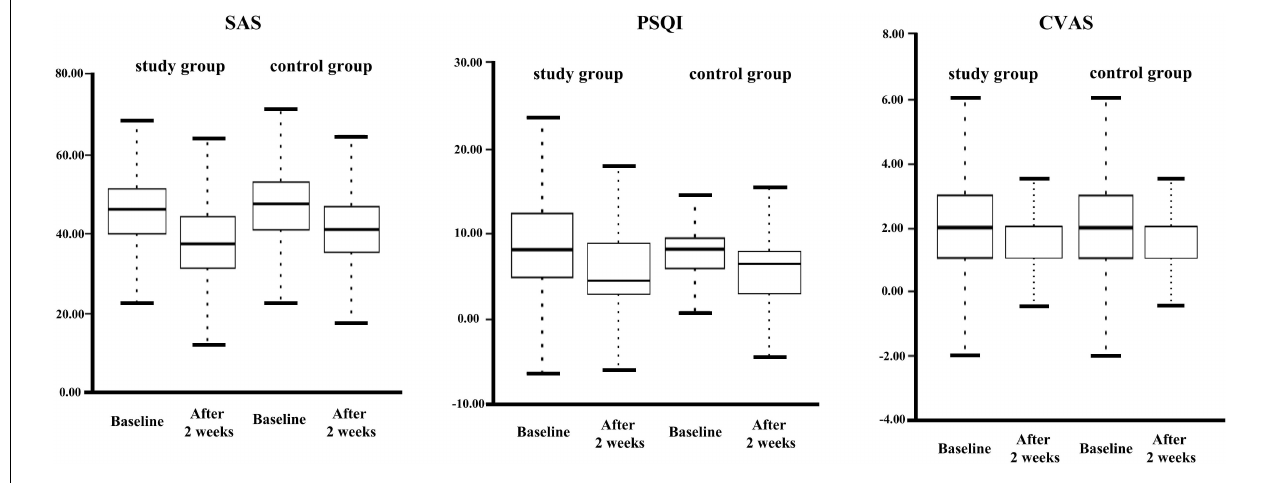
FIGURE 2 | Box-polt of inter- and intra-group comparisons at baseline and after 2 weeks of treatment. TABLE 2 | Inter- and intra-group comparisons of self-rating assessments of clinical indicators at baseline and after 2 weeks of treatment.